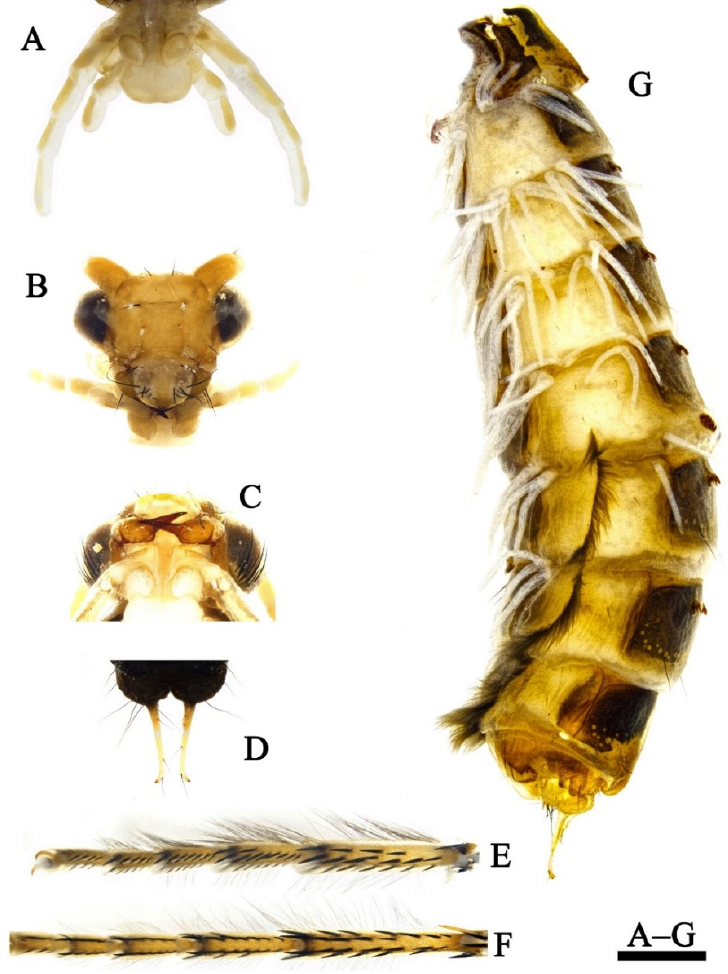
Figure 12. Limnephilus deqianensis n. sp. , pupa. ( A ) Maxillary and labial palps; ( B ) labrum; ( C ) mandibles; ( D ) anal appendages; ( E ) abdomen; ( F ) midtarsus; ( G ) hind tarsus. Scale bar: 1 mm. Female genitalia. Tergum VIII subrectangular in dorsal and lateral views (Figure 5A,B). Sternum VIII in lateral view (Figure 5B), subrectangular. Segment IX in dorsal view (Figures 5A and 6B), trapezoid, in lateral view (Figures 5B and 6A), somewhat subrectan- gular, with paired button-like processus. Segment X fused with segment IX, tubular in both caudal and lateral views (Figures 5B,C and 6A,D), with upper portion deeply incised anteriad. Vulvar scales (Figures 5F and 6C), with median vulvar lobe semicircular and paired lateral vulvar lobes each triangular. Spermatheca (Figures 5E,G and 6E,F) somewhat elliptic, spermathecal sclerites slightly sclerotized, each with lateral margin arc-shaped, with apodeme straight and strongly scerotized, somewhat calvate; processus spermath- eca obviously divided into 2 sections, anterior section slightly sclerotized, saccular in lateral view (Figures 5G and 6E), and vase-like in dorsal view (Figure 5E); posterior section membranous, elliptic in lateral view (Figure 5G) and somewhat circular in dorsal view (Figure